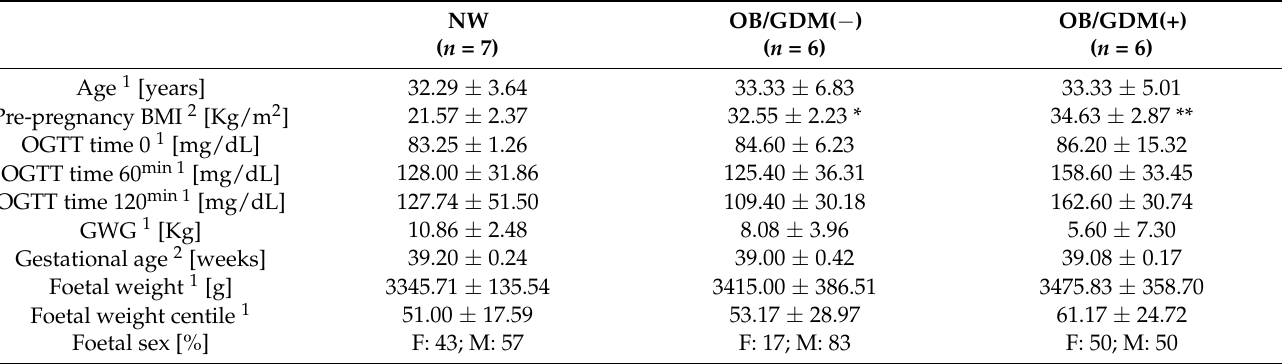
Table 1. Maternal and foetal characteristics of the population.